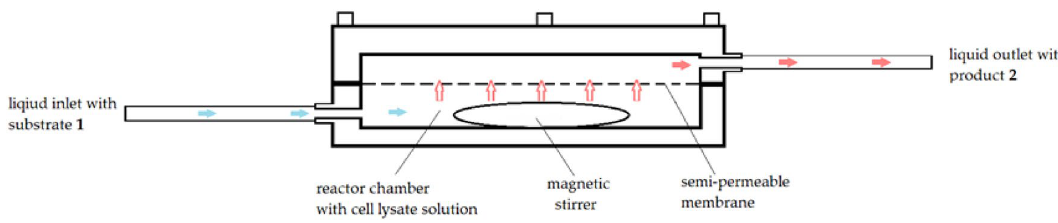
Figure 8. Scheme of reactor system with a semi-permeable membrane between cell lysate and massoia lactone ( 1 )